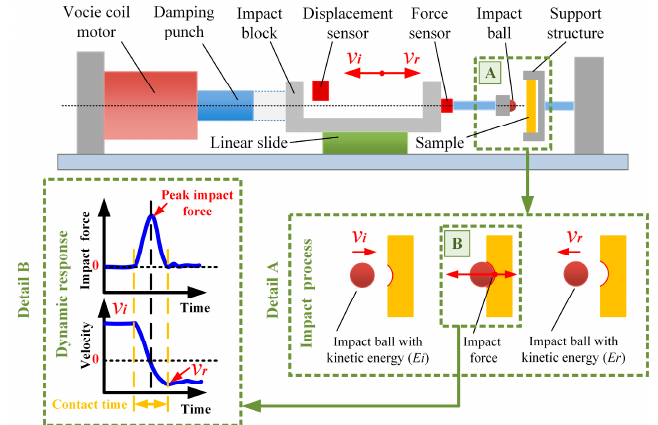
Figure 2. Schematic representation of cyclic impact tester: ( A ) the detail of impact process; ( B ) the detail of dynamic response.